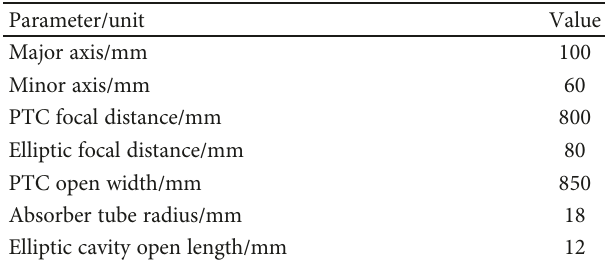
Figure 1: Schematic of a cavity tube receiver in the PTC. Table 1: Parameters of the PTC, cavity, and tube